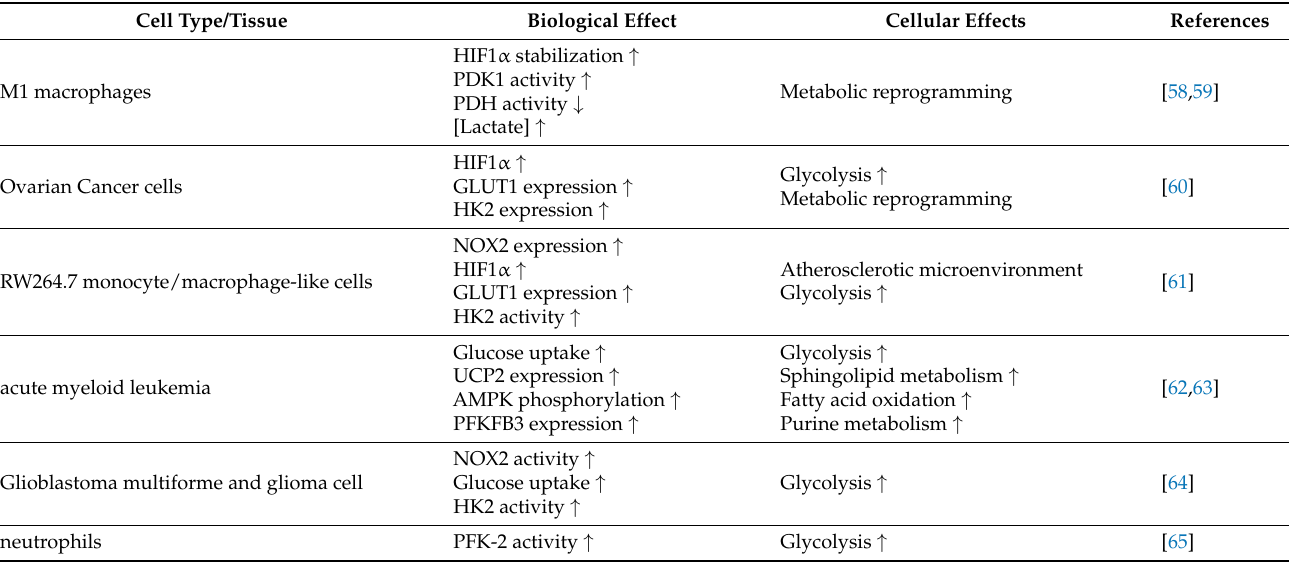
Table 2. NOX2 implication in cell metabolism